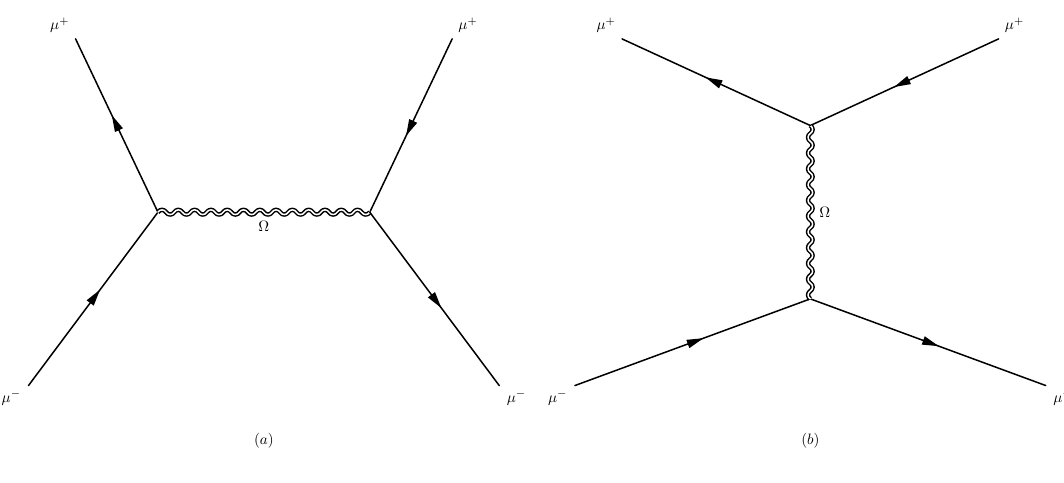
Figure 2 . Feynman diagrams which give rise to the scattering process µ − µ + → µ − µ + : (a) s - channel; (b) t